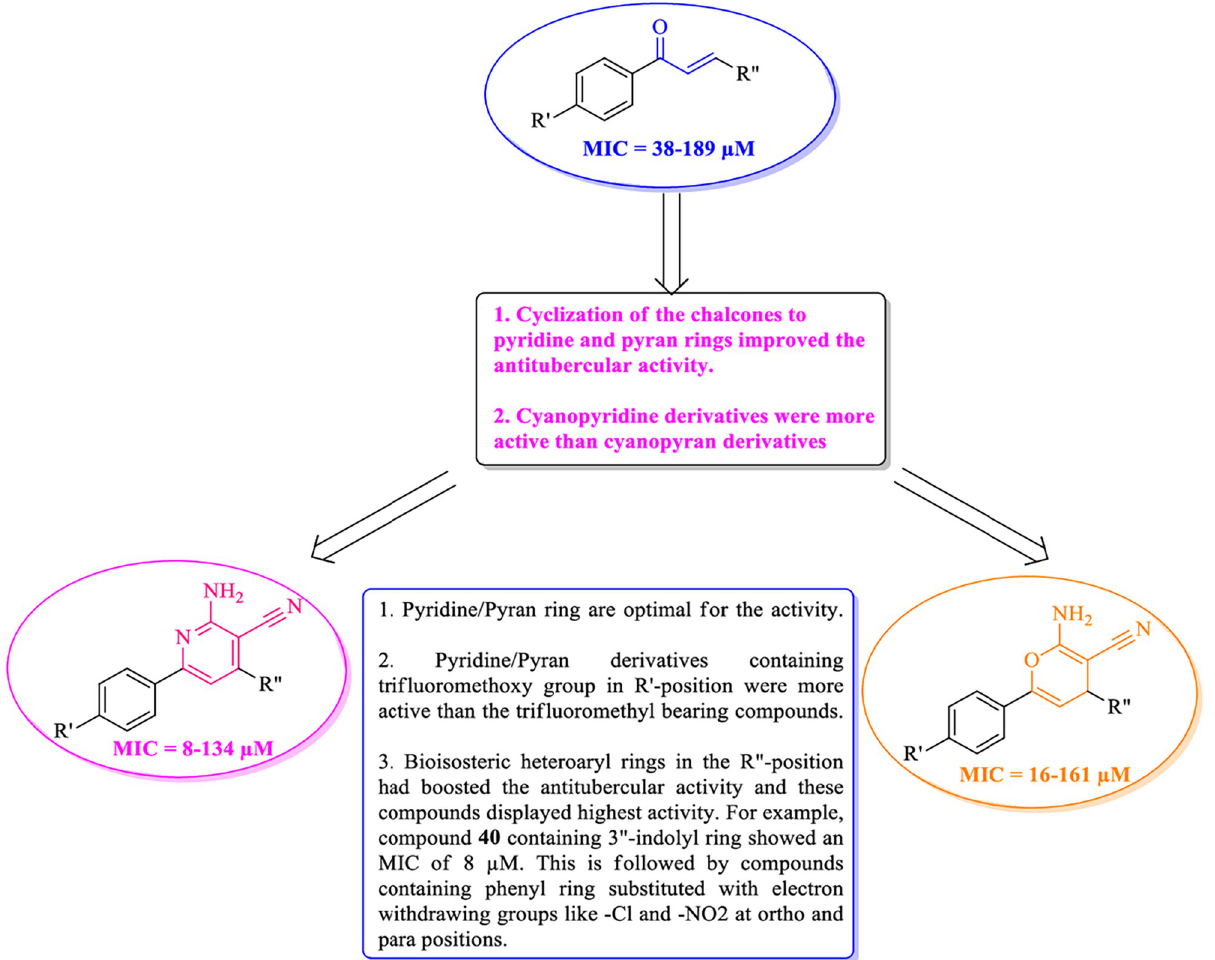
Fig 5. Structure activity relationships of fluorinated chalcones (1–20), 2-amino-pyridine-3-carbonitrile (21–40) and 2-amino-4H-pyran- 3-carbonitrile (41–60) derivatives.